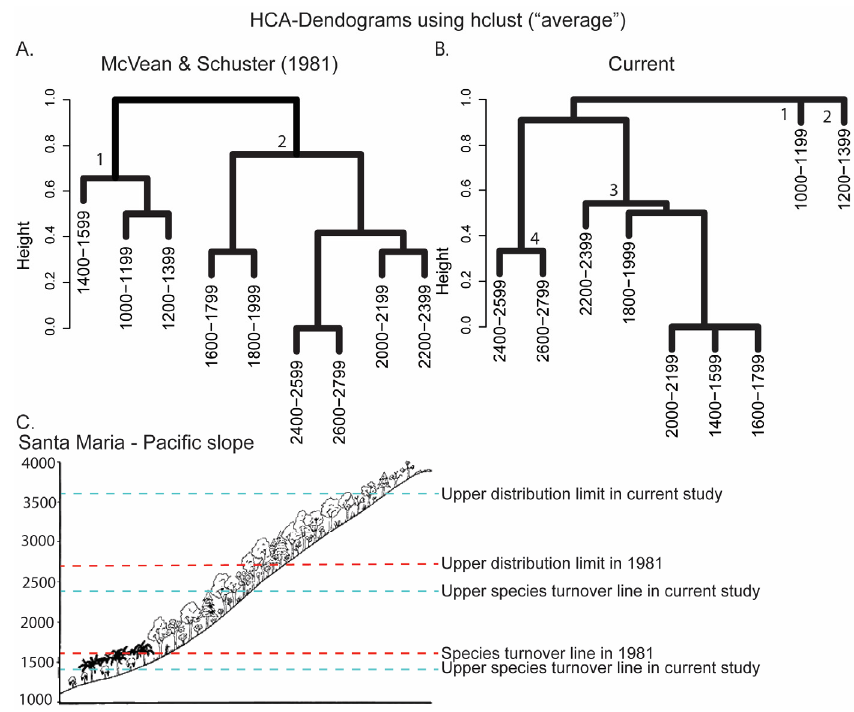
Figure 3. ( A ) Dendrogram of the HCA for the presence–absence of passalid beetle species in 200 m altitudinal belts (m a.s.l.) for the Santa Maria volcano in 1981. ( B ) Dendrogram of the HCA for the presence–absence of passalid beetle species in 200 m altitudinal belts (m a.s.l.) for the Santa Maria volcano in the current study. ( C ) Pacific slope of the Santa Maria volcano, modified from McVean and Schuster (1981), showing the species turnover line and upper distribution limit of Passalidae for each sampling period.